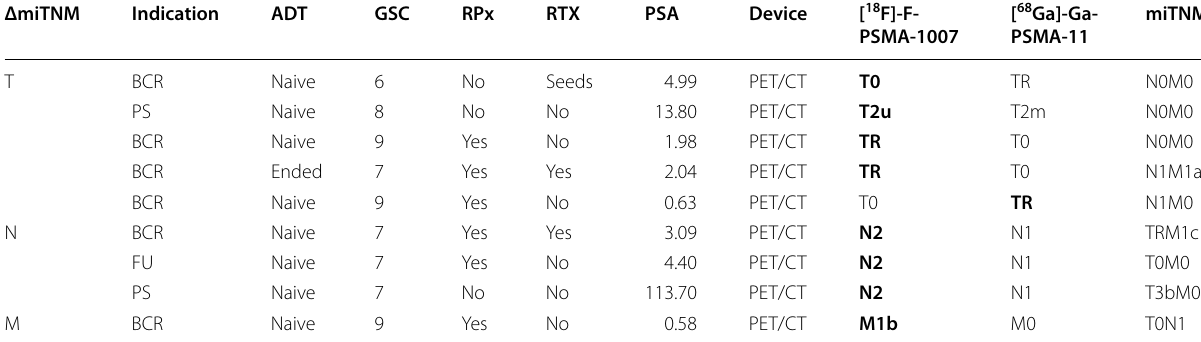
ADT, androgen depriving therapy; GSC, Gleason Score, RPx, radical prostatectomy RTx, radiotherapy, BCR, biochemical recurrence; PS, primary staging; FU, follow-up; T2u (unifocal) T2m (multifocal), TR (local recurrence). Clinical consensus was made on the bold stage